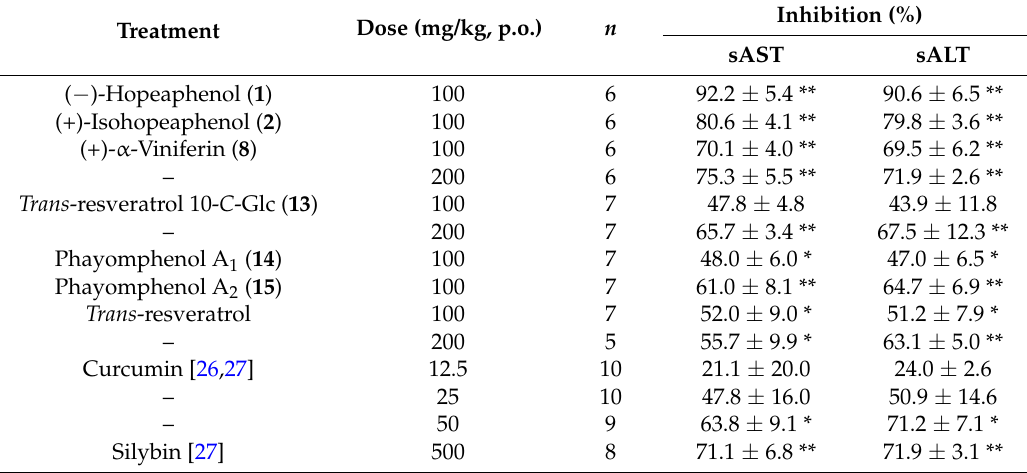
Inhibitory effects of principal polyphenol constituents ( 1 , 2 , 8 , and 13 — 15 ) on D -GalN/lipopolysaccharide (LPS)-induced liver injury in mice. Treatment Dose (mg/kg, p.o.) n